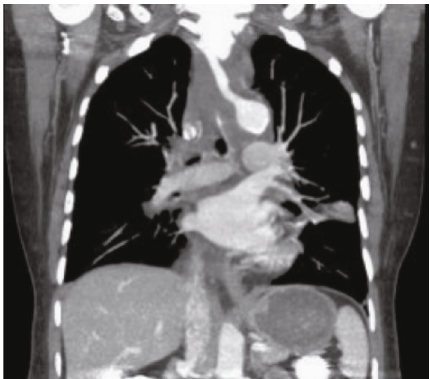
Figure 1: CT scan demonstrating ill-de fi ned fl uid collection in the superior mediastinum (arrow).